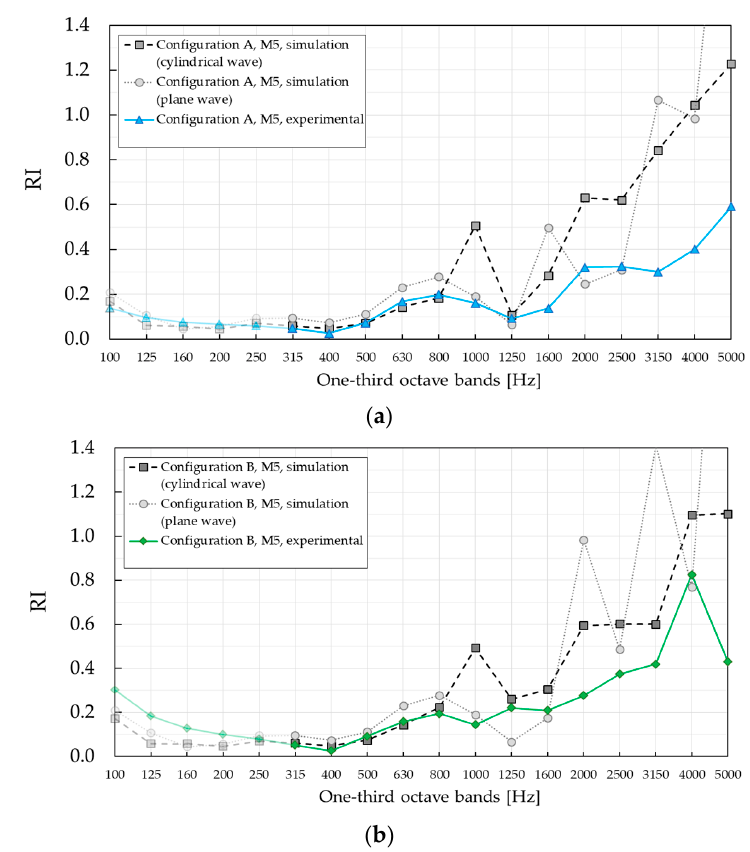
Figure 14. Comparison of RI experimental and FE simulations results averaged over three microphone positions–M4, M5 and M6. ( a ) Sound reflection index RI , configuration A. ( b ) Sound reflection index RI , configuration B.